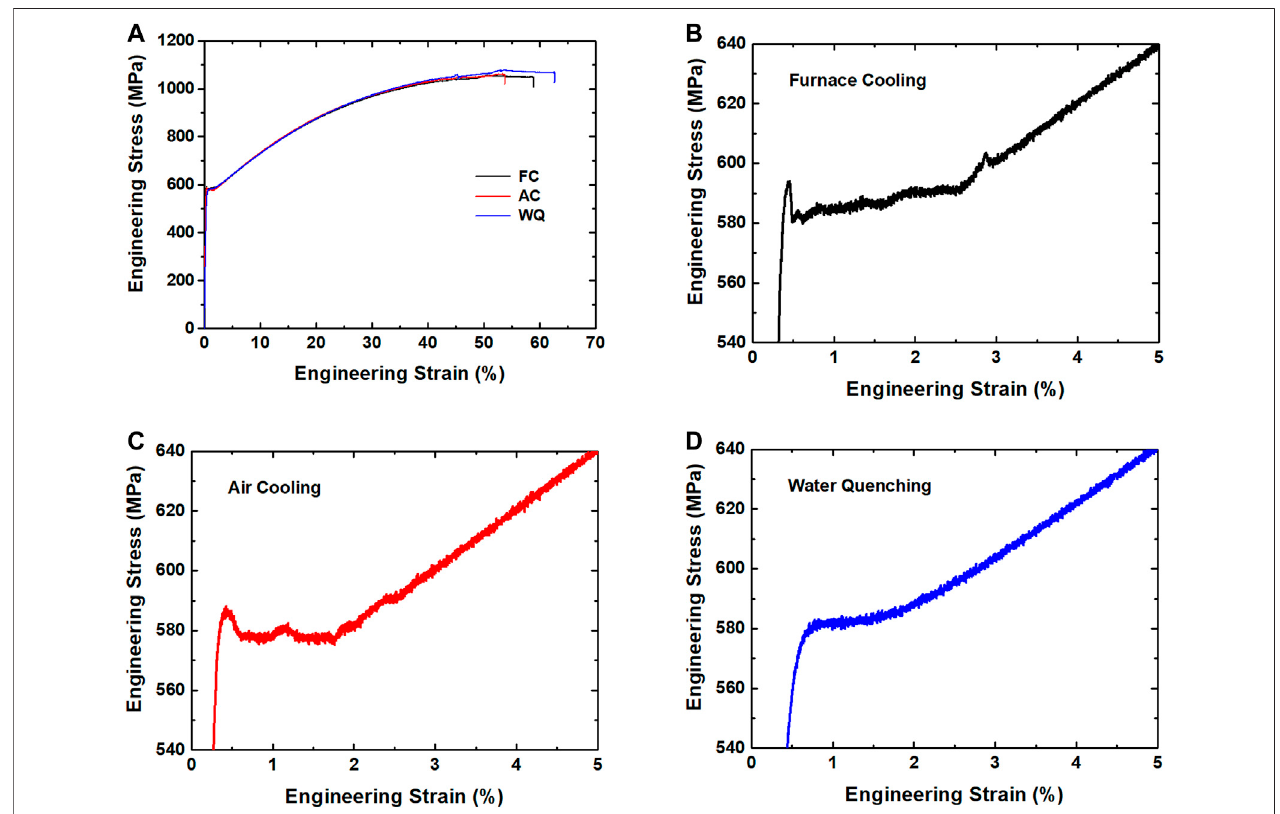
FIGURE 3 | (A) Engineering stress-strain curves of the Fe-18Mn-0.6C-1.5Al twinning-induced plasticity (TWIP) steel specimens annealed at 700 ° C for 5 min with three different cooling conditions. The initial sections of the stress-strain curves for the (B) furnace cooling (FC), (C) air cooling (AC), and (D) water quenching (WQ) conditions represent their yielding